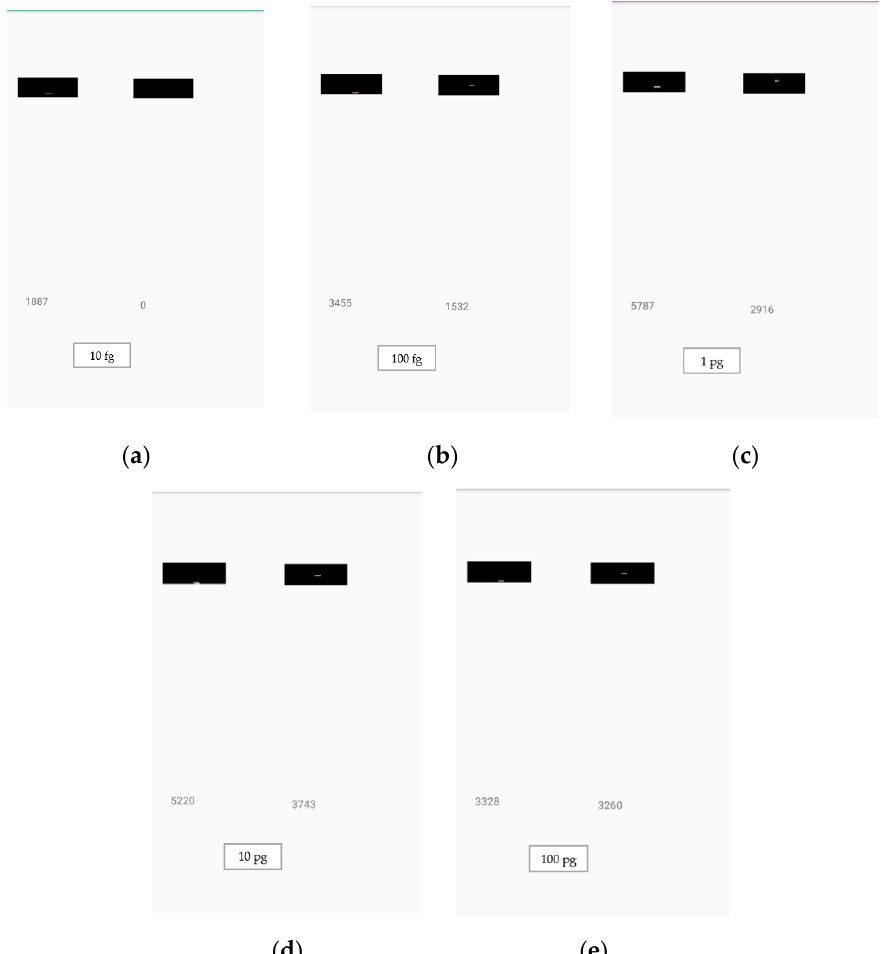
Figure 16. Estimation of analyte quantity: ( a ) 10 fg, ( b ) 100 fg, ( c ) 1 pg, ( d ) 10 pg, and ( e ) 100 pg, using